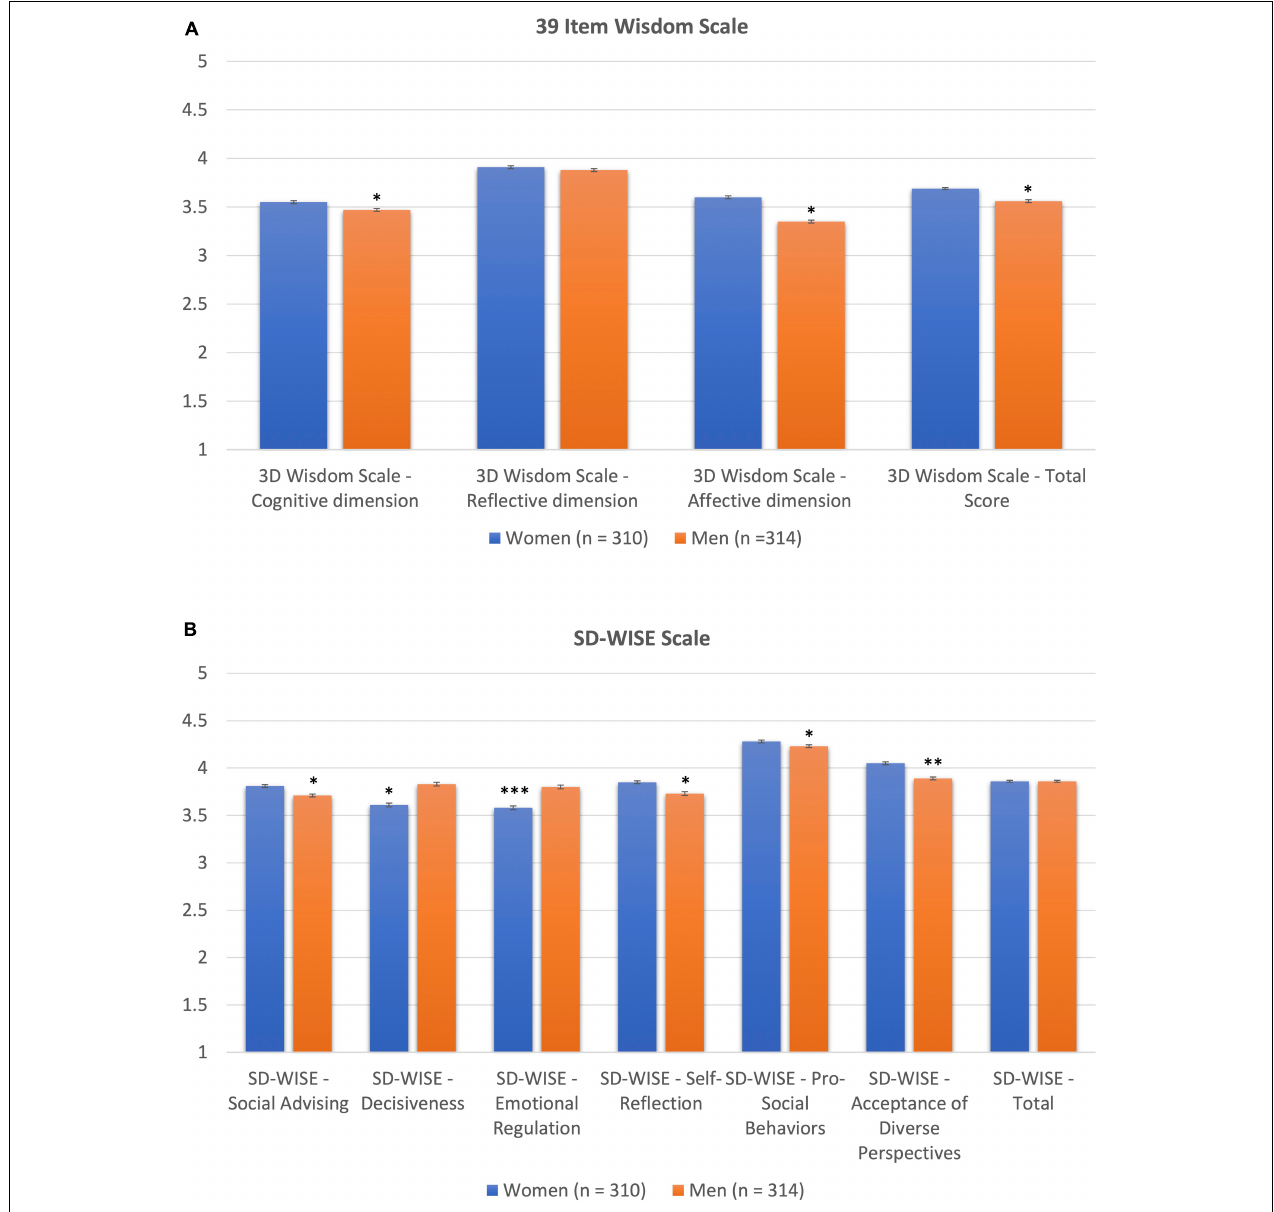
FIGURE 1 | (A) Gender differences in 3D Wisdom Scores. (B) Gender differences in SD-WISE scores. ∗ p < 0.05, ∗∗ p < 0.01, ∗∗∗ p < 0.001. Error bars represent standard